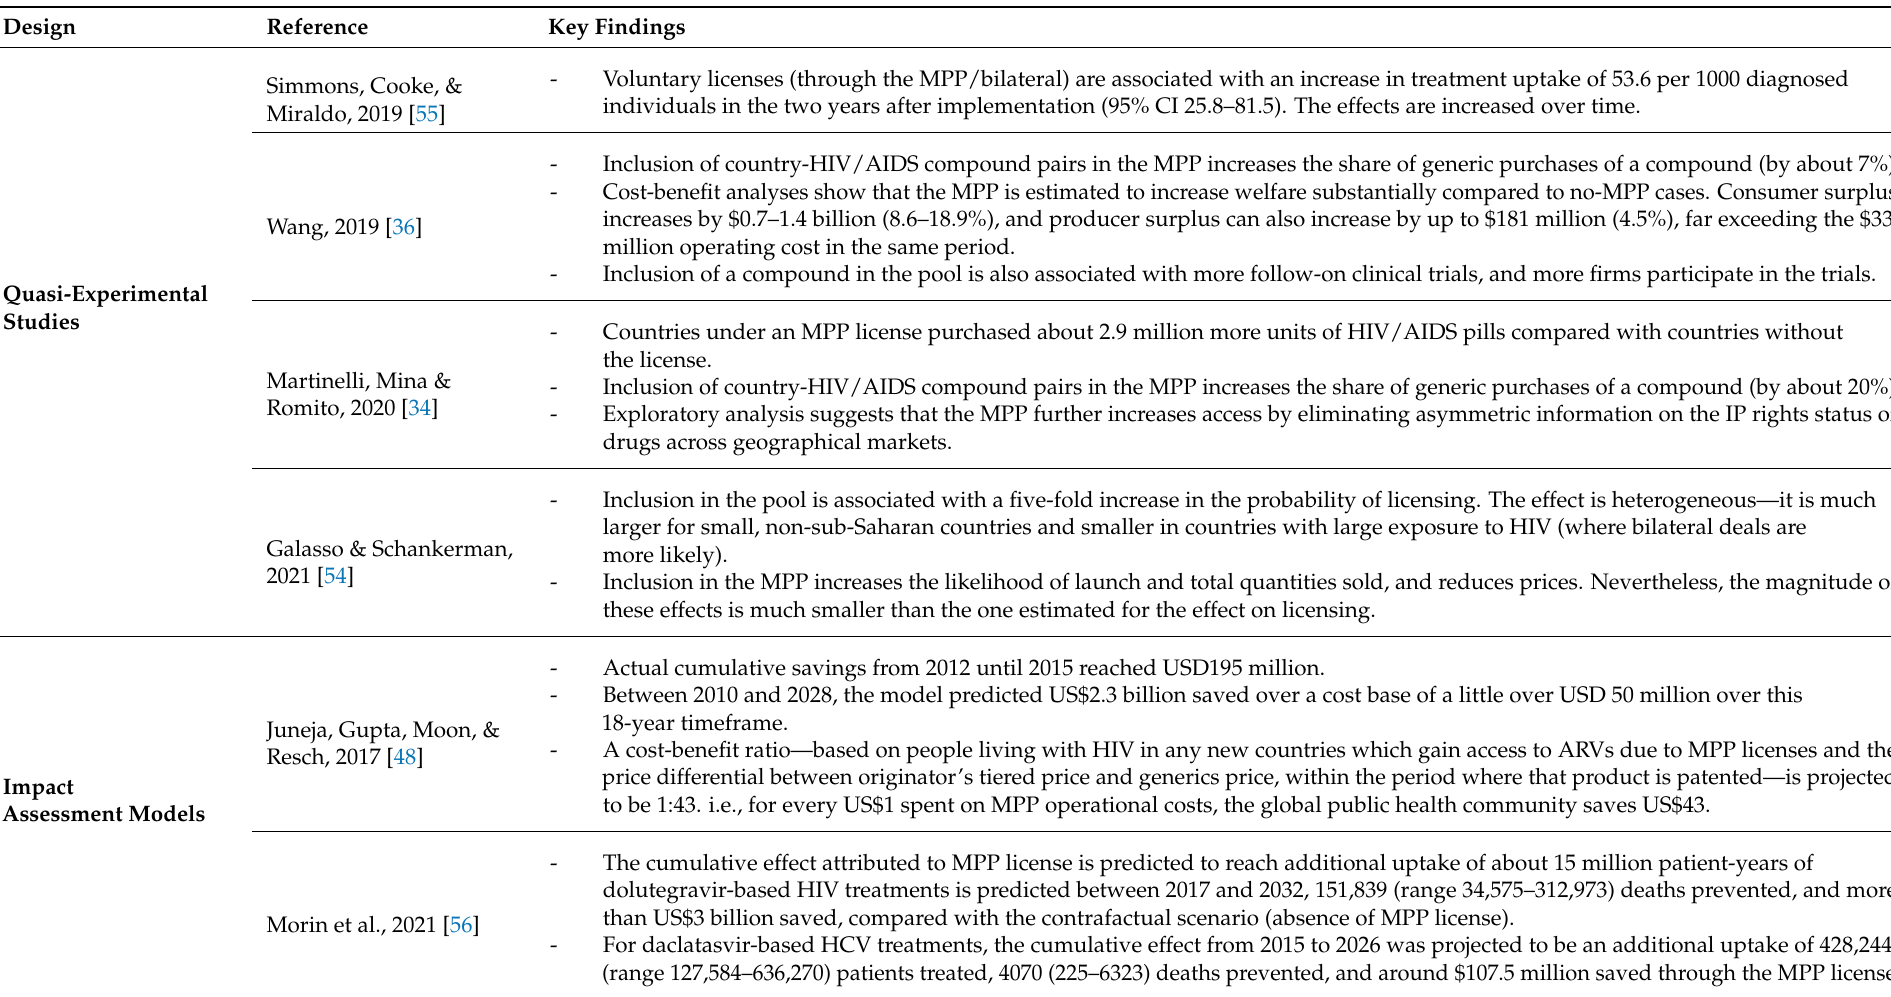
Table 3. Summary of Key Findings: The Impact of Pooled Licensing on Access to Essential